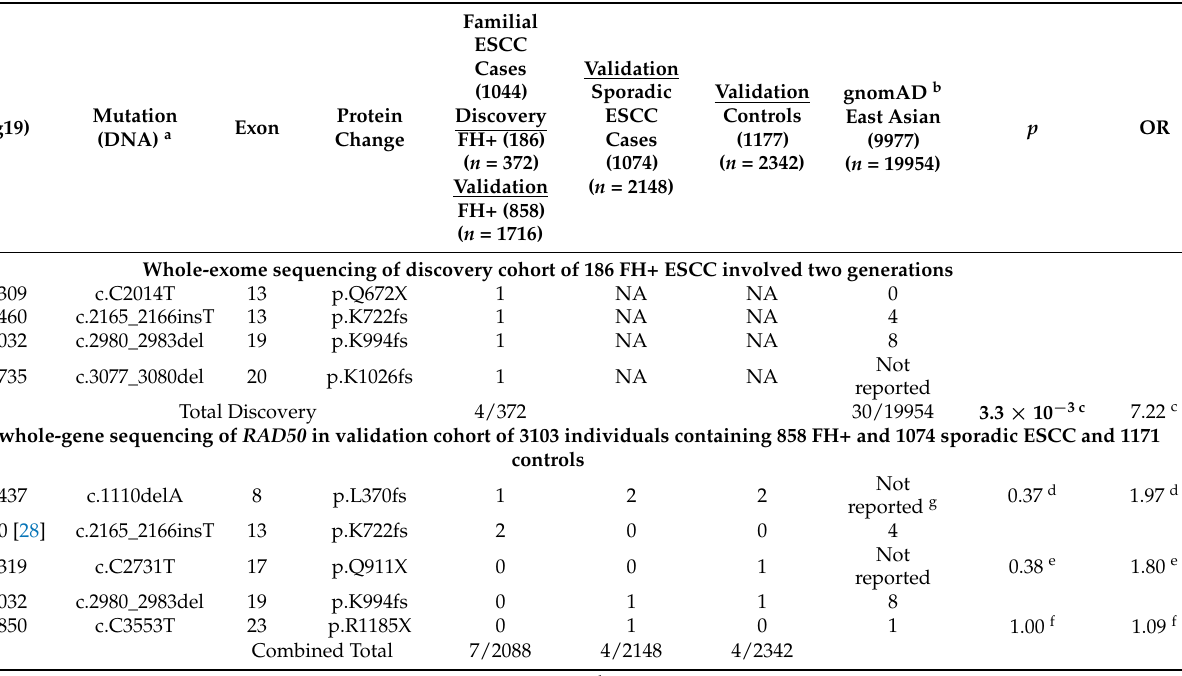
Table 2. RAD50 LOF mutations identified in familial Chinese ESCC patients, sporadic ESCC, and controls in 3289 individuals from